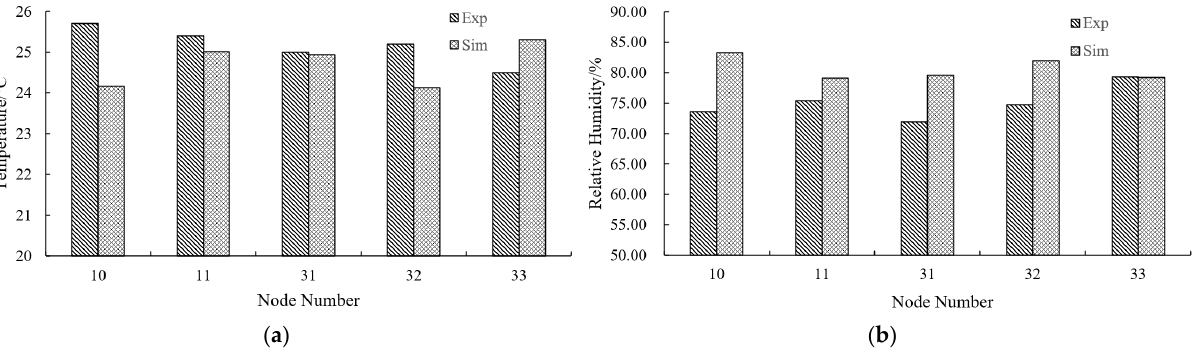
Figure 5. Measured value compared with simulated value: ( a ) comparison of measured and simulated temperature; ( b ) comparison of measured and simulated humidity.